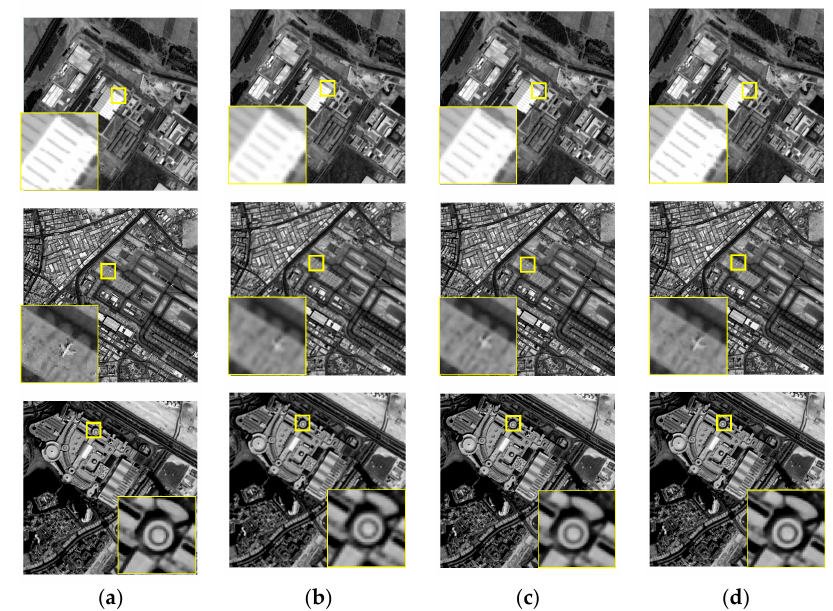
Figure 4. Simulation results of ZY-3 satellite image ( a ) Original remote-sensing image; ( b ) Bicubic; ( c ) SRCNN; ( d ) AMDE-SR.